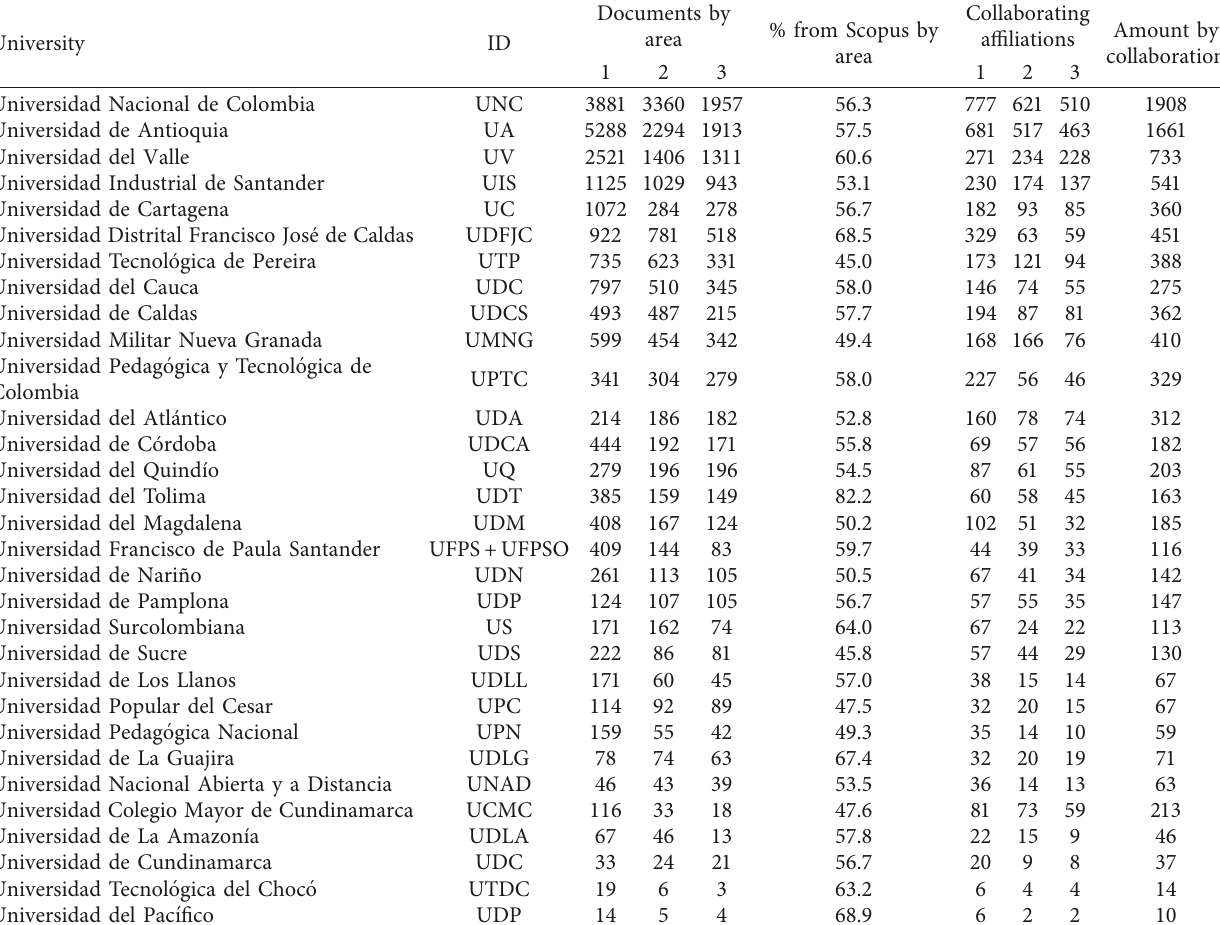
Table 2: Publication areas and collaboration of the universities in